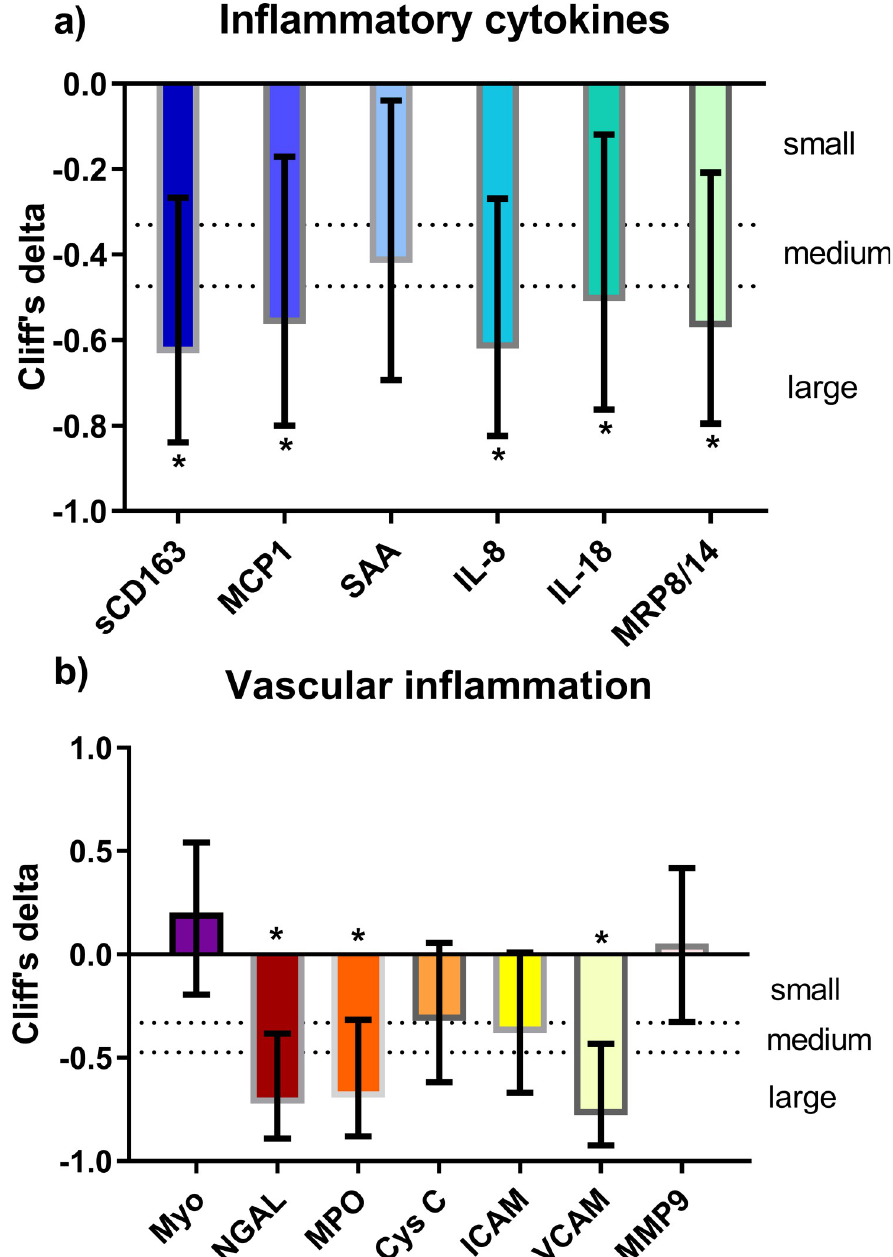
Fig 2. Non-parametric effect size (Cliff’s delta) and 95% confidence interval (error bars) of the effect of ART on a) inflammatory cytokines and b) markers of vascular inflammation. sCD163, soluble CD163; MCP-1, monocyte chemoattractant protein-1; SAA, serum amyloid A; IL-8, interleukin 8; IL-18; interleukin 18; MRP8/14, myeloid- related protein 8/14 (calprotectin); NGAL, neutrophil gelatinase-associated lipocalin; MPO, myeloperoxidase; Cys C, cystatin C; ICAM, intercellular adhesion molecule VCAM, vascular cell adhesion molecule 1; MMP-9, matrix metalloproteinase-9. � p < 0.05 significant reduction compared to baseline. https://doi.org/10.1371/journal.pone.0282728.g002 subsequently limiting the capacity to reduce vasomotor tone. In HIV, several factors can affect the vasculature, including endothelial dysfunction [30], RAAS hyperactivation, infection of vascular smooth muscle cells, increased coagulation, chronic immune activation (by the virus